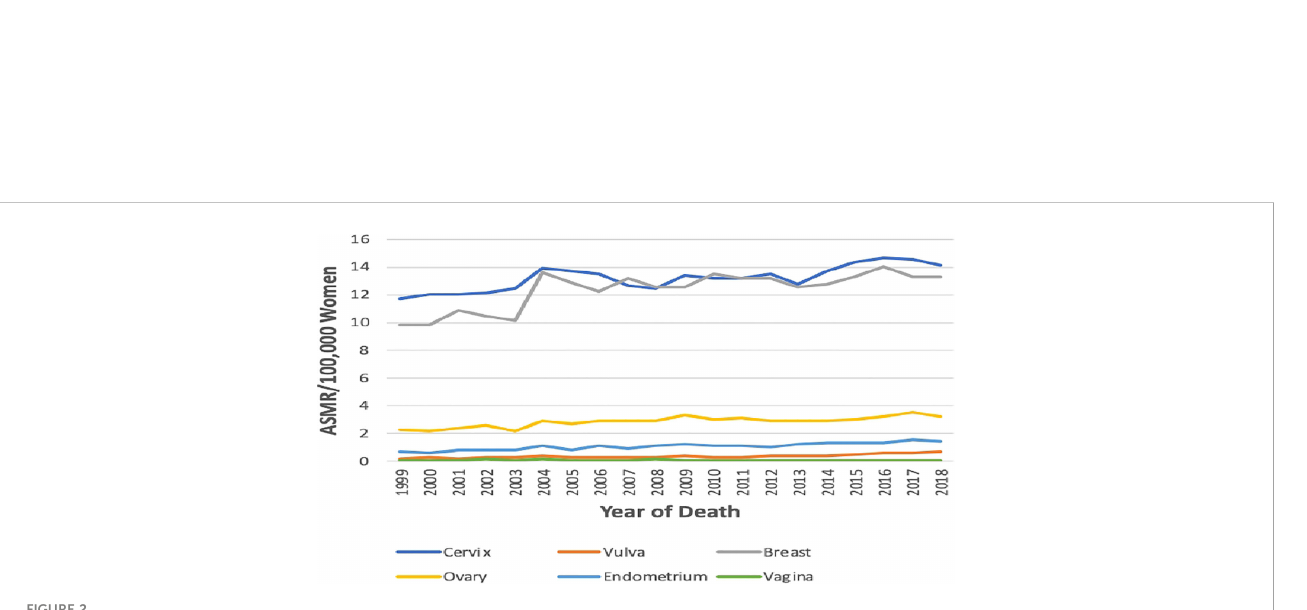
FIGURE 2 Trends in age-standardized mortality rates of breast and Gynaecological cancers in South Africa from 1999 to 2018.